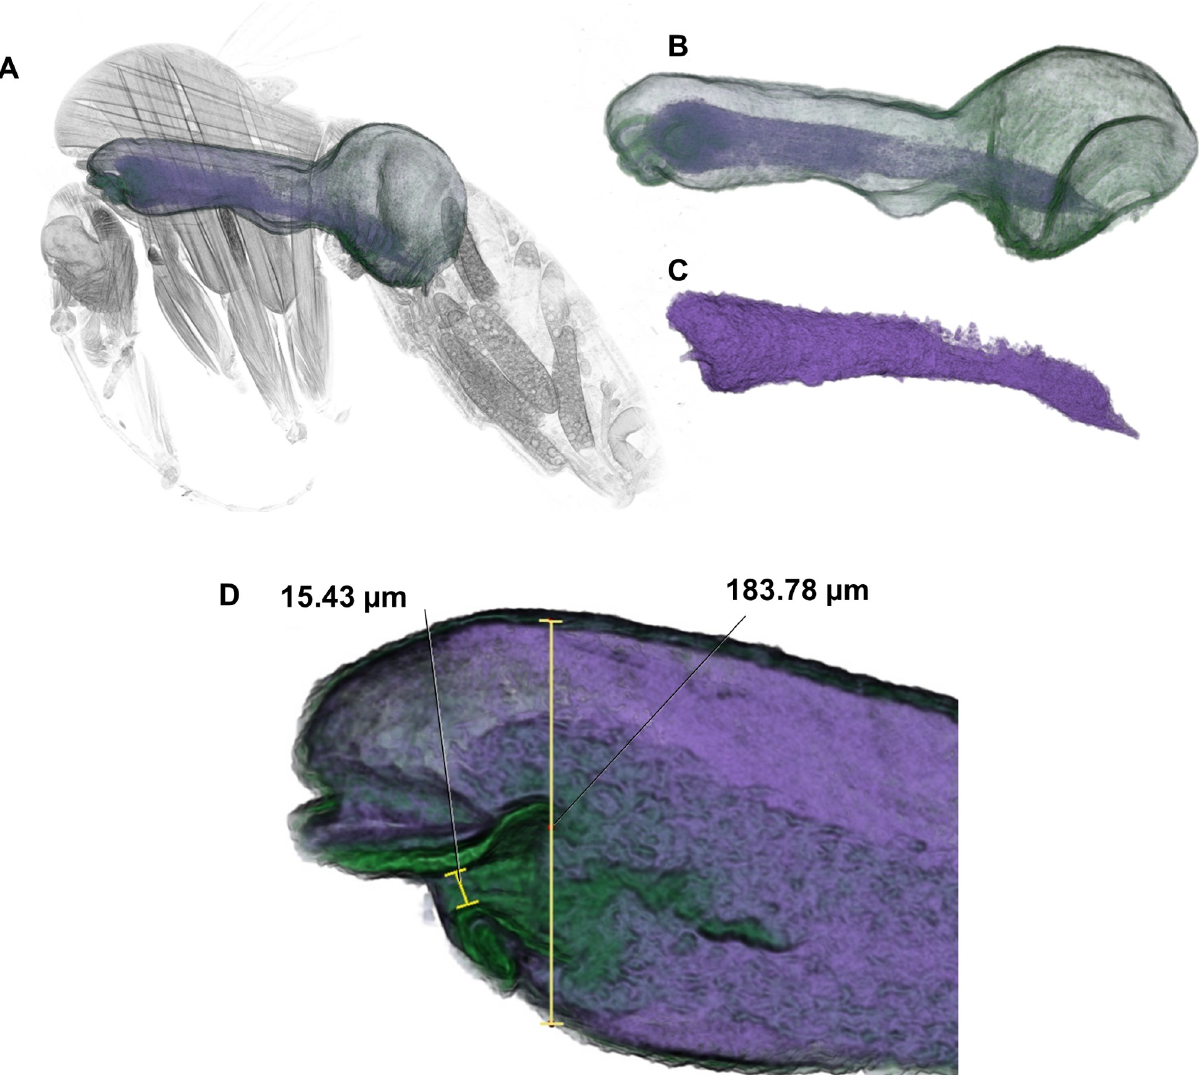
Fig 3. False-colour 3D-surface models of the whole fly (A), midgut (B) and PSG-parasite plug (C) of a T9INF+ infected female L . longipalpis (9 days after an infected blood meal and 4 days after a second, non-infected blood meal) created by software segmentation (sand fly number 12 (35) in Table 1). Segmentation of the midgut (B, green) out of the fly enabled volume measurement (0.037 mm 3 ; thoracic midgut only = 0.013 mm 3 ). The PSG-parasite plug (C, purple) was then segmented out of the midgut enabling volume measurement (0.0052 mm 3 , corresponding to 14.2% of the total midgut volume; thoracic midgut only = 0.0039 mm 3 and 29.8%). Note the forward projection through the stomodeal valve of the PSG-parasite plug at the anterior (upper) end. The diameter of the stomodeal valve opening and of the midgut immediately posterior to the valve were measured in